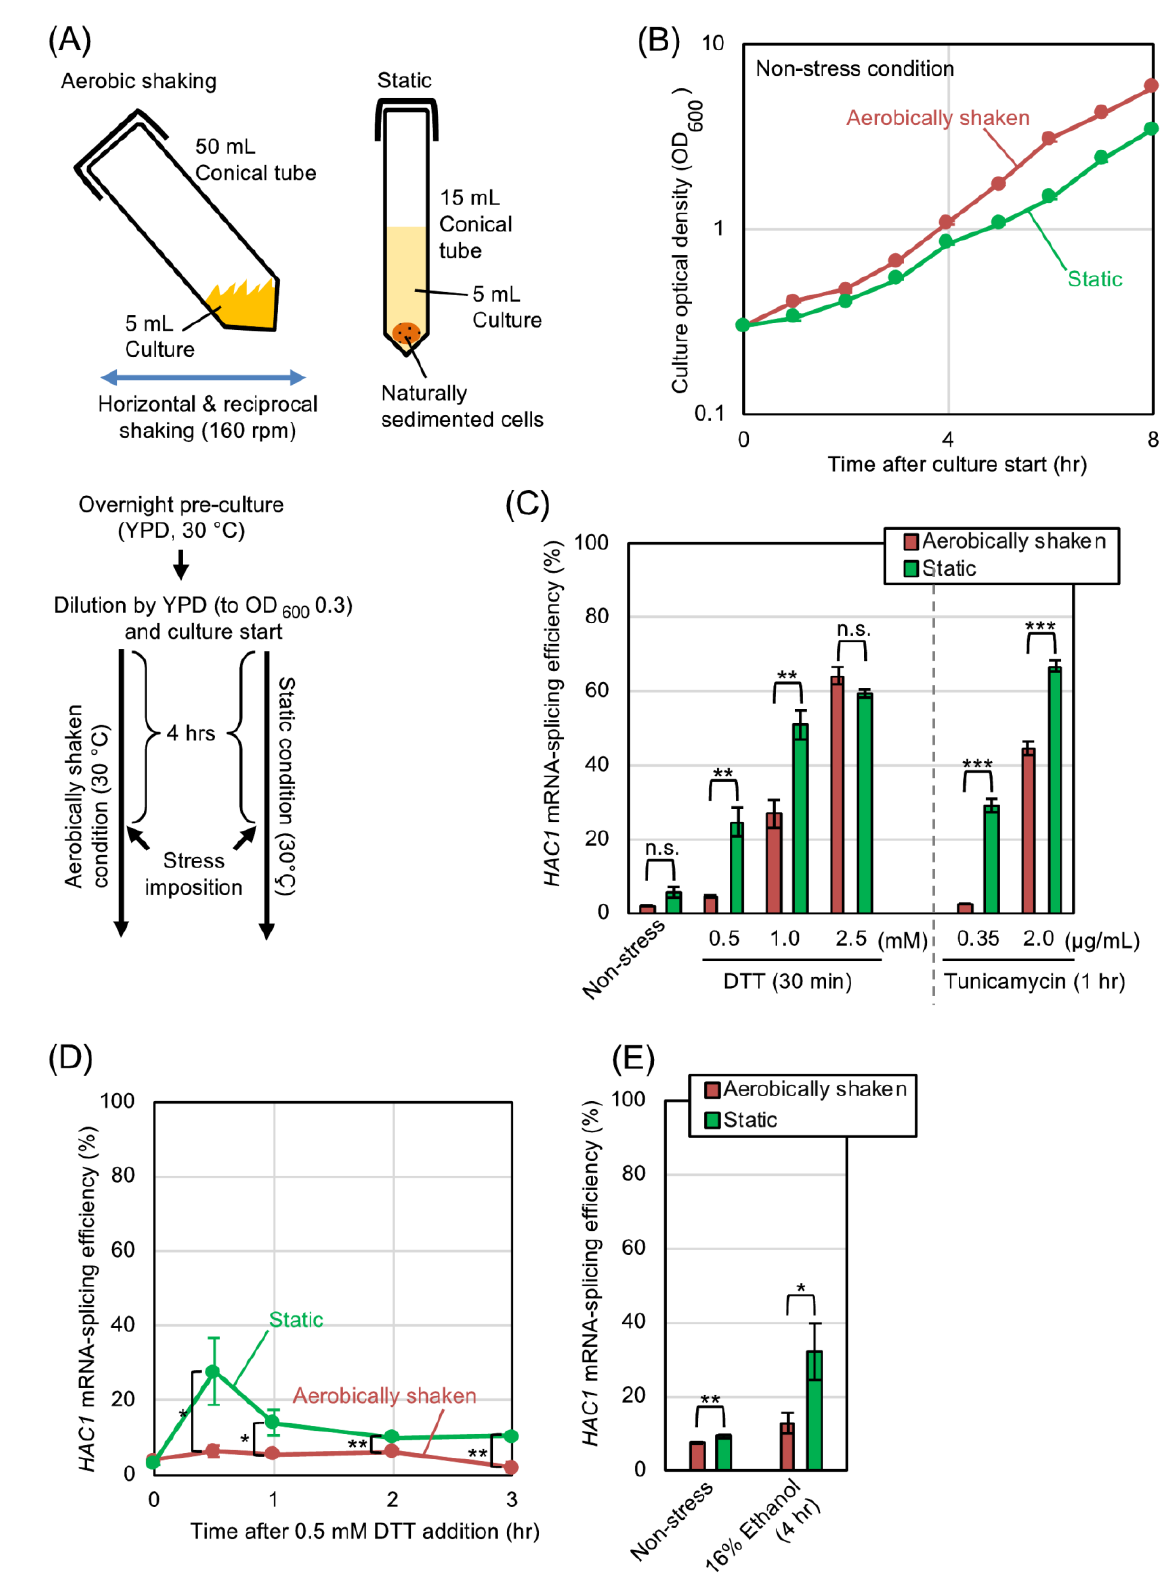
FIGURE 1: HAC1 -mRNA splicing is compromised by aerobic agitation. (A) Procedures for culturing and ER-stress induction of S. cerevisiae cells under the aerobically shaken condition or under the static condition. ER-stress agents (DTT, tunicamycin, or ethanol) were added to the media 4-hr after culture start. (B) Optical density of cultures (wild-type BY4742 cells) was monitored under non-stressing conditions. (C-E) Wild-type BY4742 cells were cultured and were ER-stressed (or remained non-stressed) as shown in panel A, and were checked for HAC1 - mRNA splicing. n.s. (not significant): p > 0.05, *: p < 0.05, **: p < 0.01, ***: p < OPEN ACCESS | www.microbialcell.com